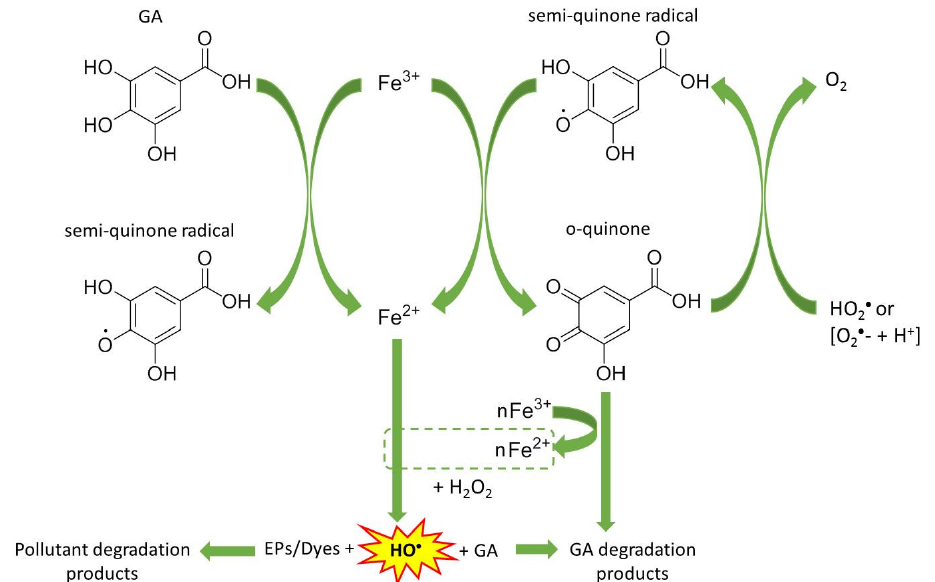
Figure 2. Reduction of Fe 3+ ions by gallic acid and its oxidized intermediates. The regenerated Fe 2+ ions can react with H 2 O 2 to generate more HO ● radicals via Fenton reaction. This illustration was adapted from Christoforidis et al. [18], with permission from John Wiley and Sons (ON